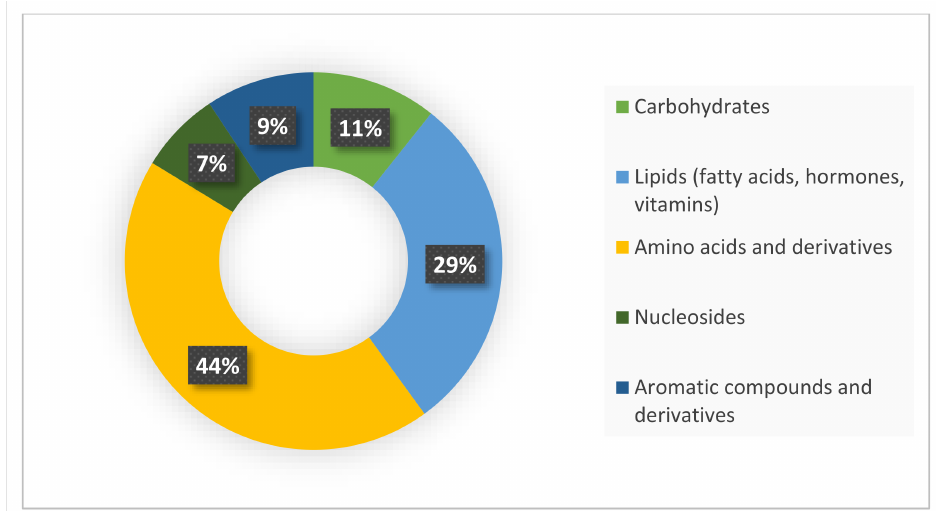
Figure 1. Chemical categories of metabolites identified in the urine of occupational and environmental workers exposed to benzene, investigated in this